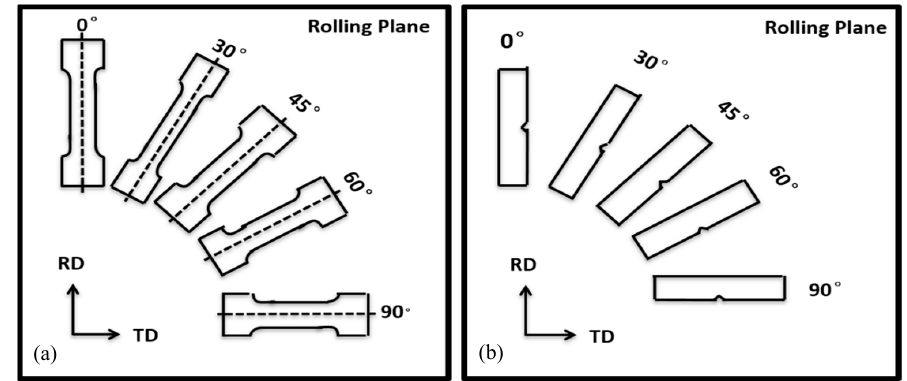
Figure 2. Orientation of the mechanical test specimens relative to the steel coil, where RD and TD stand for the rolling and transverse directions respectively: ( a ) directions of tensile test specimens and ( b ) different orientation of the Charpy impact and DWTT specimens.